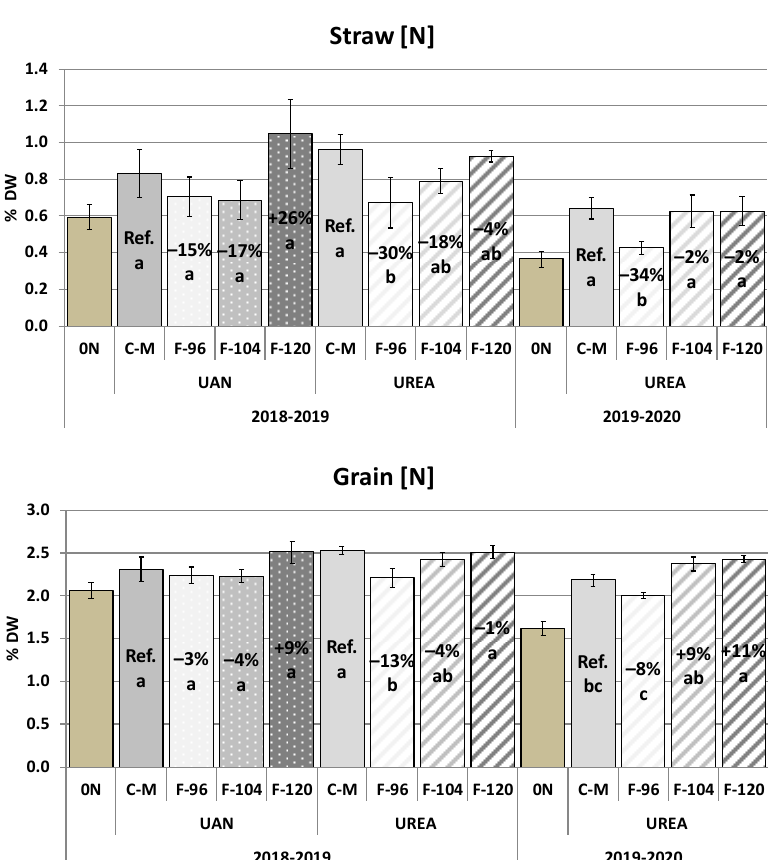
Figure 3. Nitrogen concentration in straw and grains at harvest (% DW ± SE; n = 3) of wheat under different foliar N fertilization treatments in a two-year field trial with UAN and urea as fertilizers. Percentages: variation vs. each conventional management C-M (Ref.). Letters: statistical comparisons among treatments within the same fertilizer (Newman–Keuls test, p ≤ 0.05). Table 5. N use efficiency (NUE), N uptake efficiency (NUpE) and N utilization efficiency (NUtE) (± S.E.; n = 3) in wheat under different foliar N fertilization treatments in a two-year field trial with UAN and urea as fertilizers. In brackets: % variation vs. each conventional management C-M. Letters: statistical comparisons among treatments within same fertilizer (Newman–Keuls test, p ≤ 0.05). N Use Efficiency N Uptake Efficiency N Utilization Efficiency NUE (NUpE) (NUtE) kg Grains/kg N-Applied kg N-Uptake/kg N-Applied kg Grain/kg